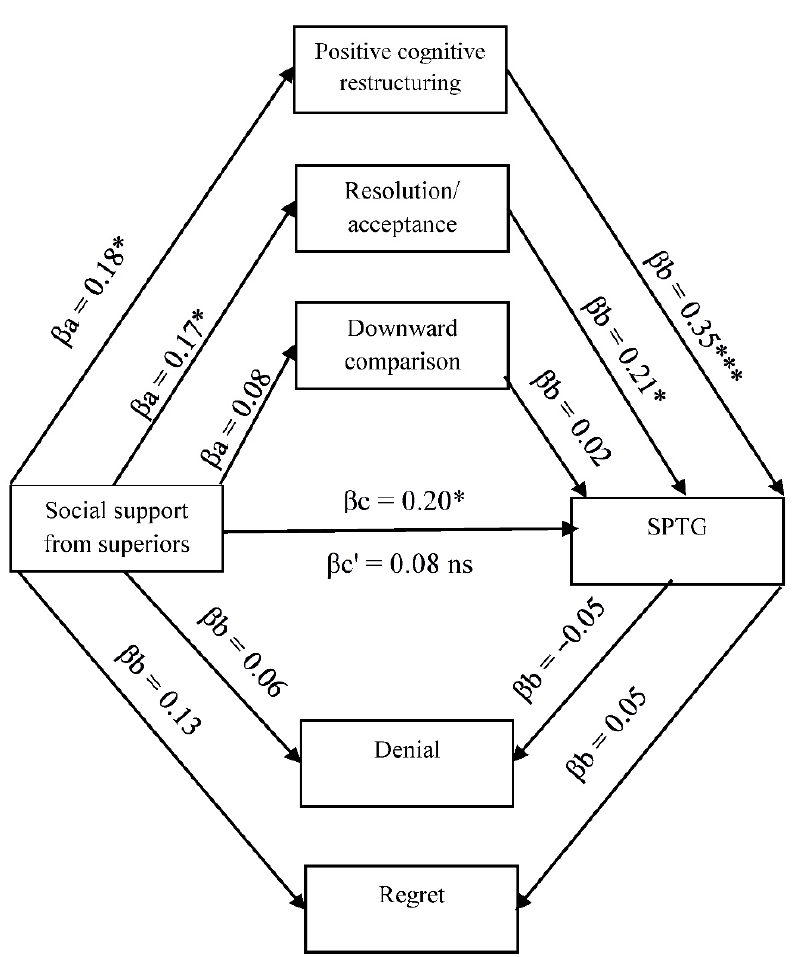
Figure 1. Model of relations between social support from superiors, cognitive processing of trauma and secondary posttraumatic growth. β a,b—indirect effect; β c—total effect; β c’—direct effect. * p < 0.05; *** p < 0.001.